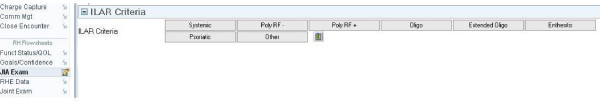
Appearance of the flow sheet rows for diagnosis within the EpicCare™ EMR. Entry of ILAR diagnosis is more accurate than can be accommodated by the ICD-9 system, implemented primarily for billing purposes. The ICD-9 system, for example, has no specific code for systemic JIA.